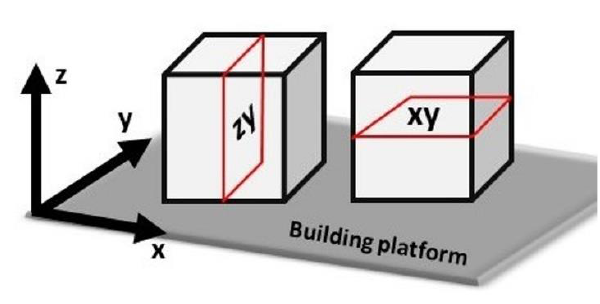
Figure 3. Schematic representation of the analyzed orientations along the zy plane (along the building direction) and along the xy plane (perpendicular to the building direction).